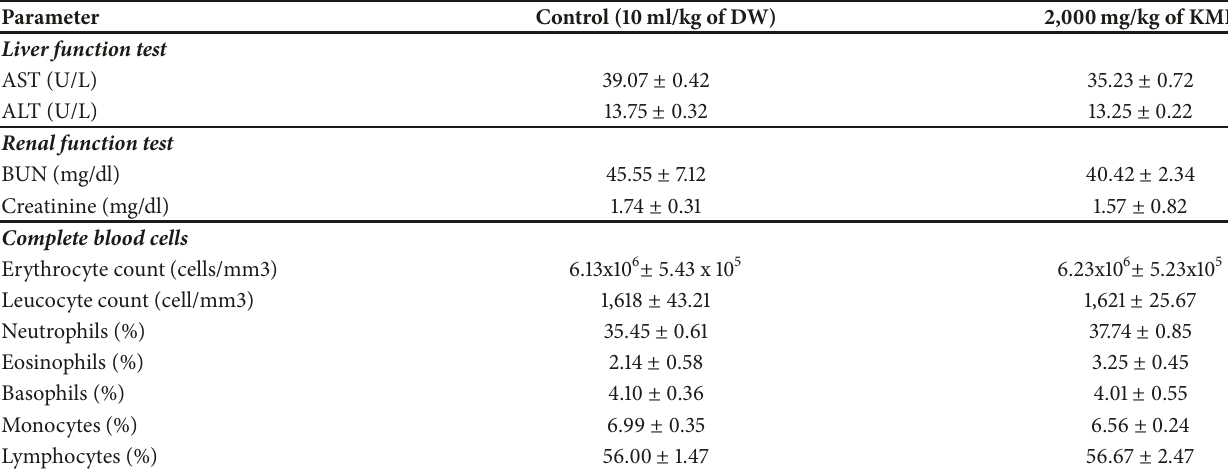
Table 1: Chronic oral toxicity of kaempferol in